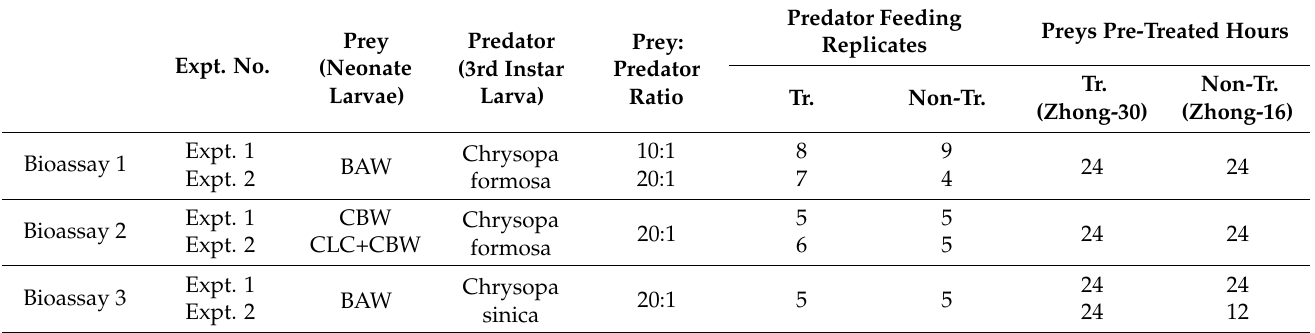
Table A1. Bioassays to investigate the effect of Bt cotton on the number of caterpillars consumed by predatory lacewing